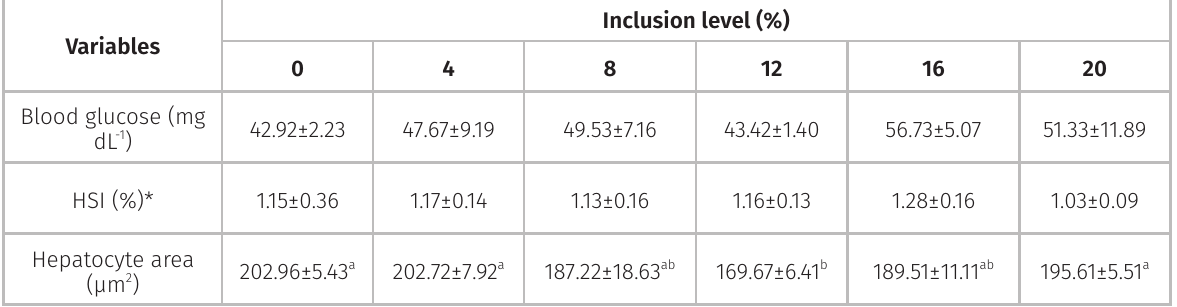
Table III. Blood glucose and hepatic parameters of Nile tilapia (Oreochromis niloticus) fingerlings fed diets containing different levels of crude glycerin inclusion.